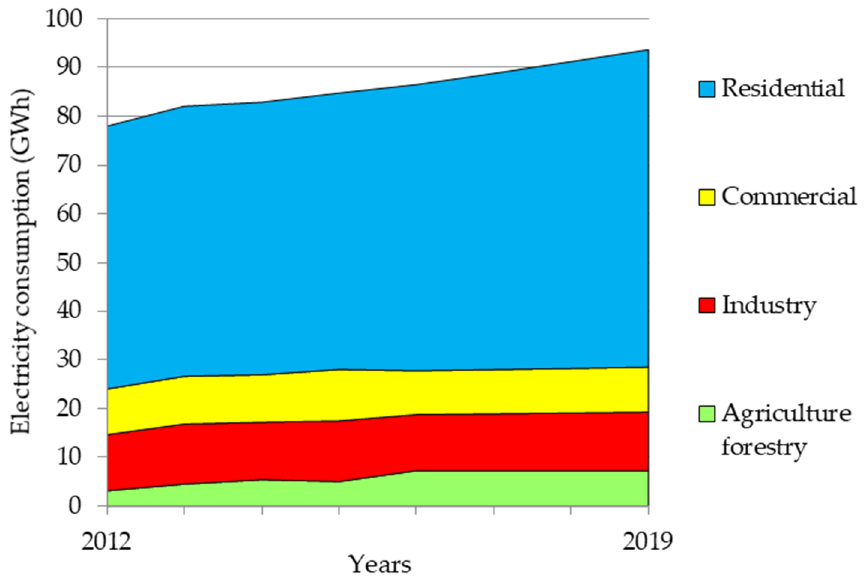
Figure 8. Electricity consumption by sector in Isla de Juventud in 2012–2019. Source: own elaboration with the model [27].